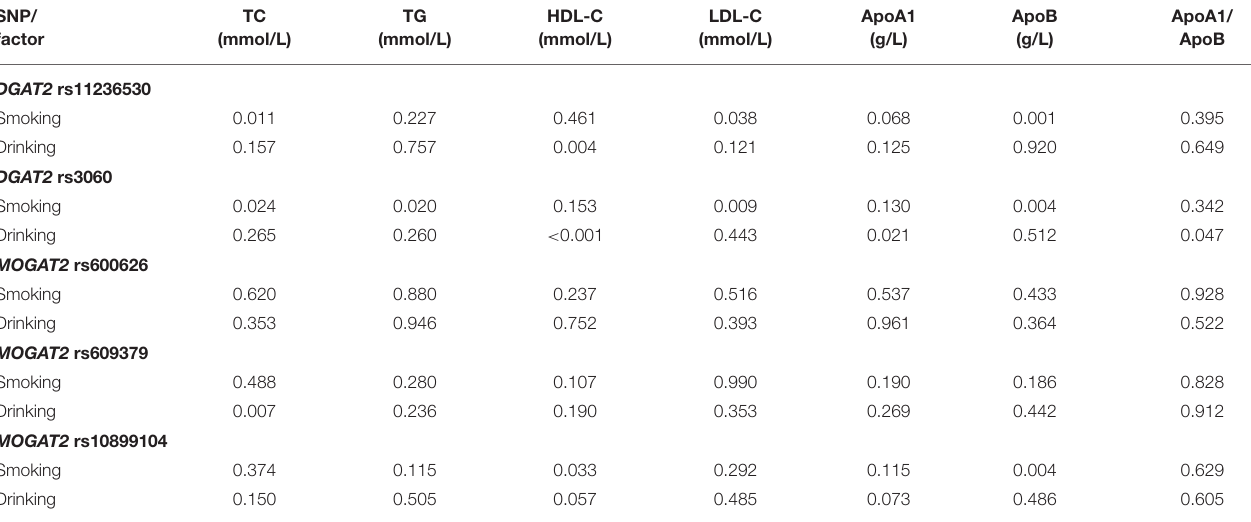
TABLE 6 | The interaction P- value ( P I ) of SNP-smoking/drinking on serum lipid levels in controls. SNP/